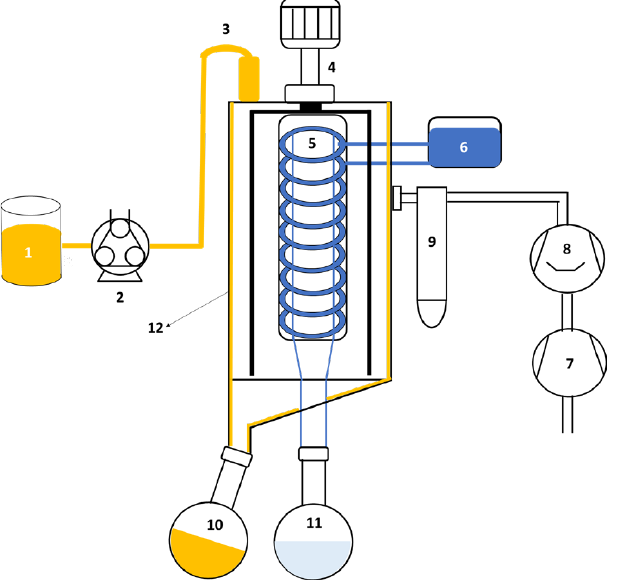
Figure 1. Simplified schematic of the molecular distillation unit: (1) essential oil tank; (2) peristaltic pump; (3) feed; (4) motor; (5) condenser; (6) condenser cooling system; (7) vacuum pump; (8) diffusion pump; (9) trap vacuum; (10) residue collector; (11) distillate collector; and (12) evaporator surface.